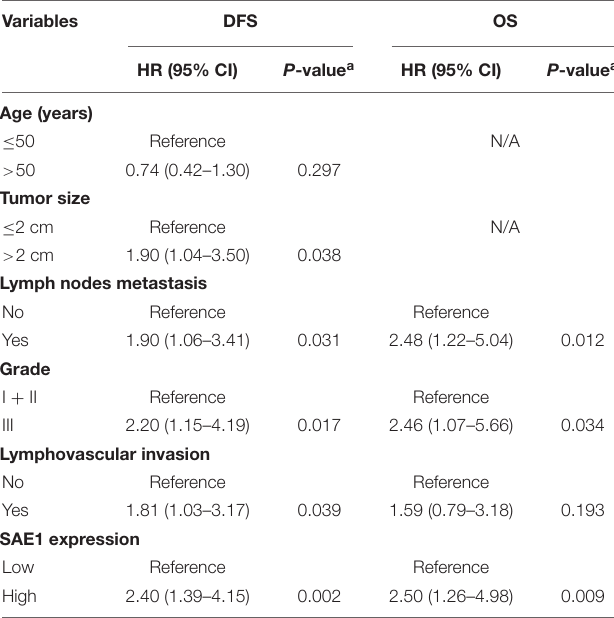
TABLE 3 | Multivariate Cox proportional hazard model for disease-free survival (DFS) and overall survival (OS) in TNBC patients with adjuvant